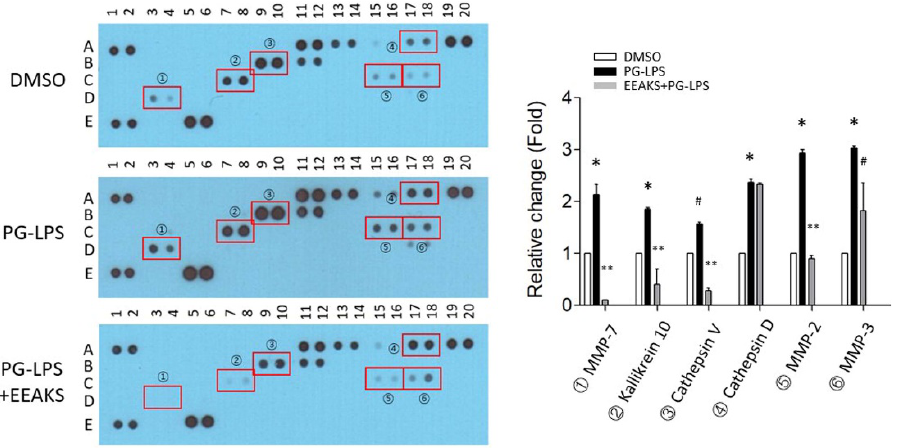
Figure 3. Effects of EEAKSs on PG-LPS-induced proteases levels. PG-LPS (1 µ g/mL) treated in IHOK cell culture medium with or without EEAKSs (10 µ g/mL) and culture medium (CM) was applied onto protease antibody array membrane. DMSO was treated as the control. Altered factors are indicated in the images as red rectangles and circled numbers. The list altered factor is shown as fold-change in the graph. * p < 0.01 vs. DMSO-treated medium, ** p < 0.001 vs. PG-LPS-treated medium, # p < 0.05 vs. PG-LPS-treated medium.